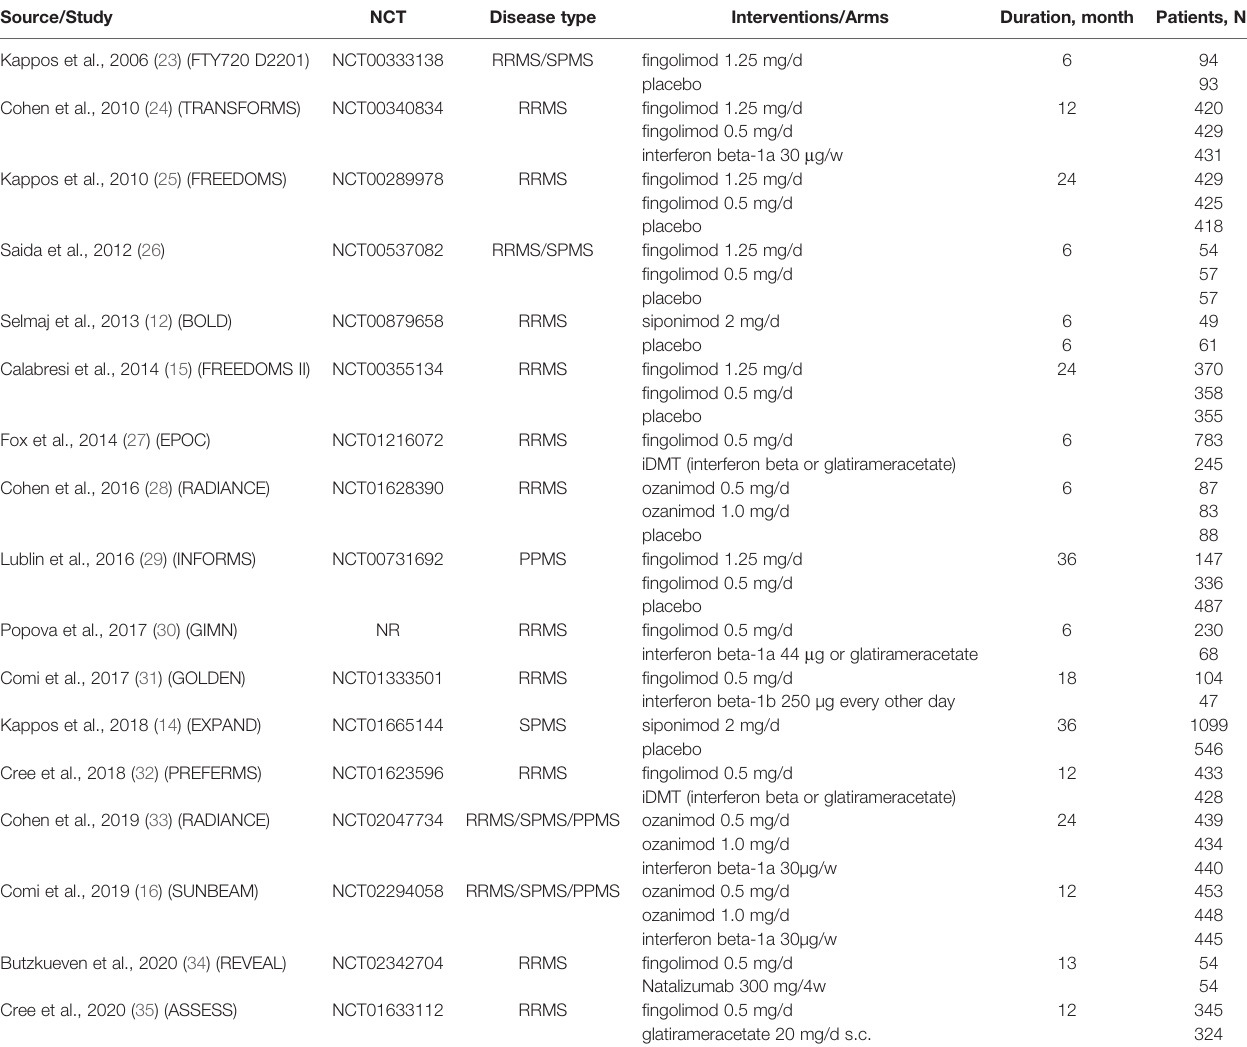
TABLE 1 | Characteristics of included studies and baseline characteristics of the population included in the RCTs. Source/Study Disease